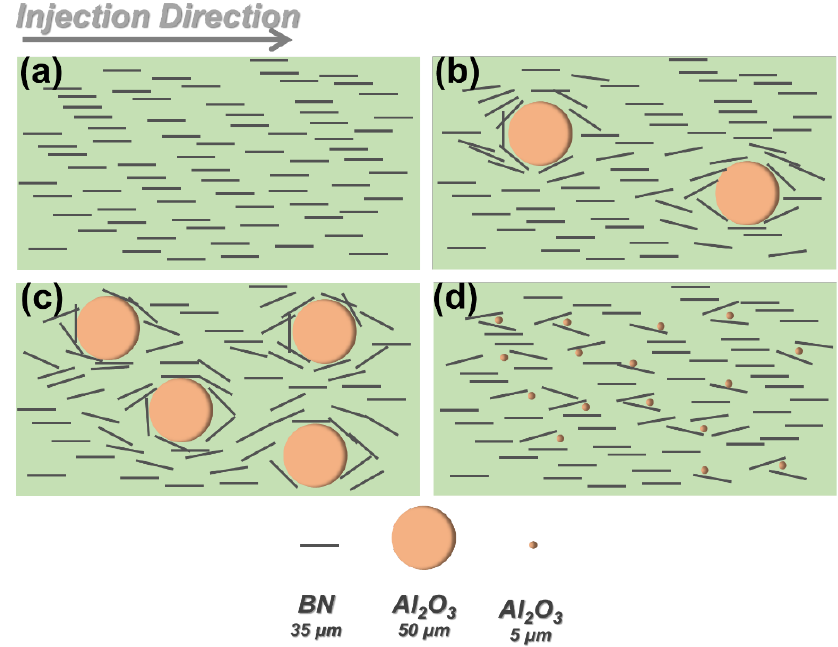
Figure 4. The schematic mechanism for thermal conductivity enhancement of PC/Al 2 O 3 /BN compo- sites with different Al 2 O 3 particle sizes and contents: ( a ) PC/BN, ( b ) PC/A L 20B, ( c ) PC/A L 40B, ( d ) PC/A S 40B.